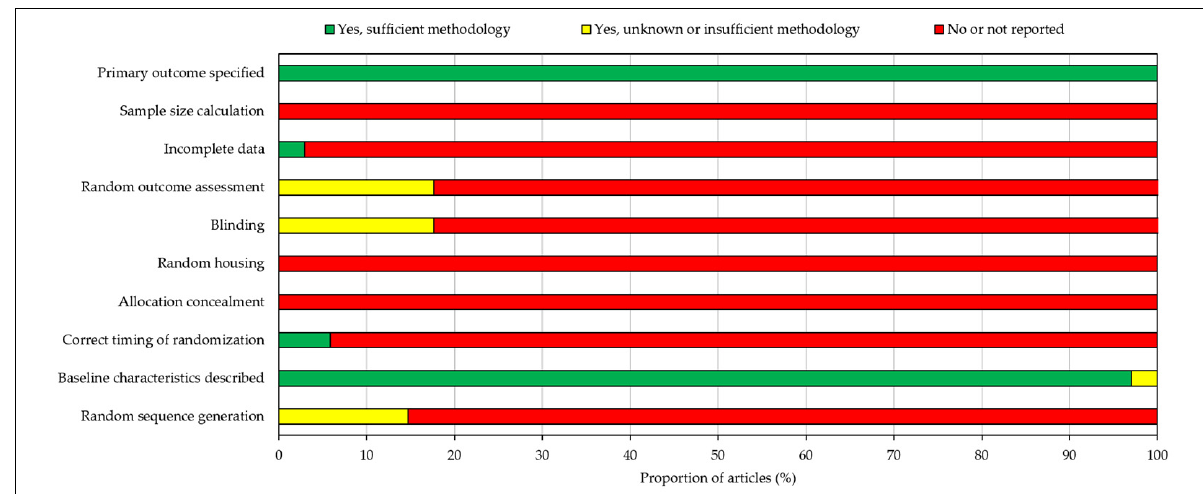
Figure 3. Risk of bias assessment according to the SYRCLE risk of bias (RoB) tool for animal studies. Risk of bias was judged to be